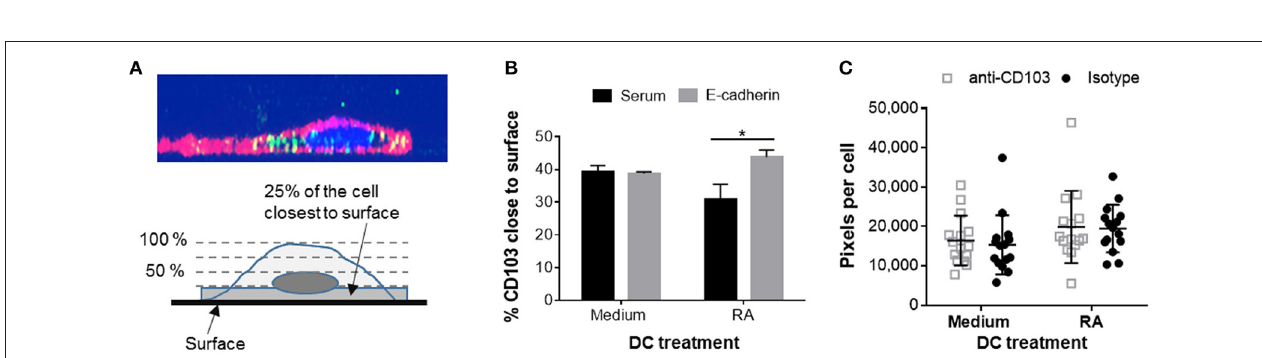
FIGURE 5 | Internalization of surface-expressed CD103 in human MoDCs. Human MoDCs were labeled with an anti-CD103 FITC (mouse IgG1), washed, and chilled with ice-cold buffer. Time zero samples were left on ice, and internalization was initiated in the remaining samples by resuspending the samples in 37 ◦ C media and incubating them at that temperature for the indicated times. Following incubation, cells were harvested with cold buffer and then left on ice until all samples were collected. Anti-CD103 antibody remaining on the surface of the DCs was detected with a secondary anti-mouse IgG1 antibody. (A) Representative FACS plots and (B) pooled data from four independent experiments show a significant decrease in surface CD103 after 40min. 2-way ANOVA with Sidak’s multiple comparisons.